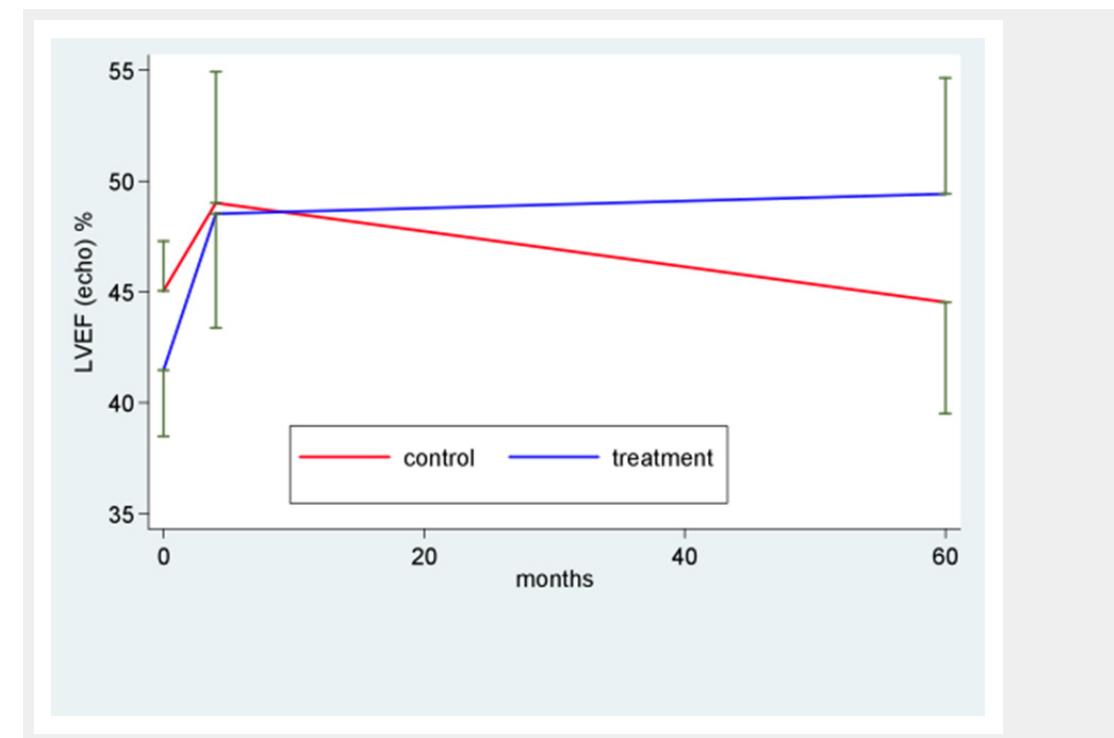
Left ventricular function directly after myocardial infarction (baseline), after 4 and 60 months. LVEF: left ventricular ejection fraction.